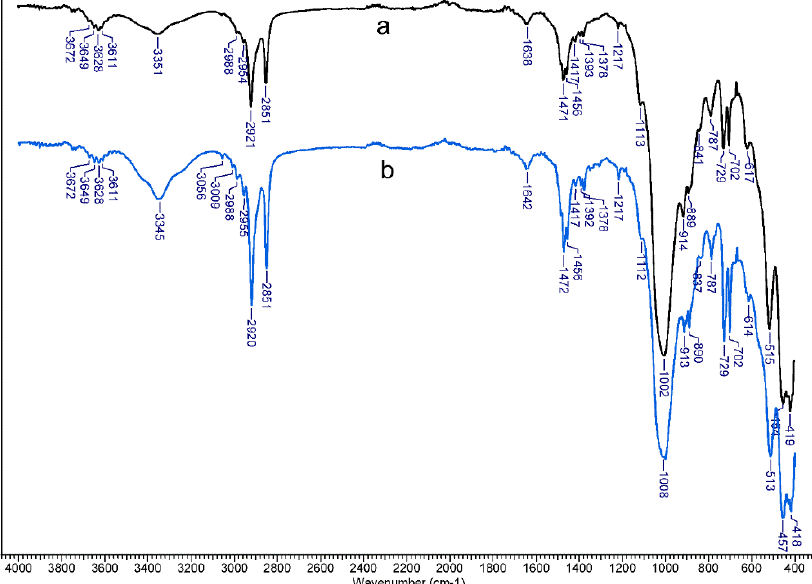
Figure 4. FT-IR spectra of BDMHDA–clay sample under: ( a ) MW free; ( b ) MW heated.